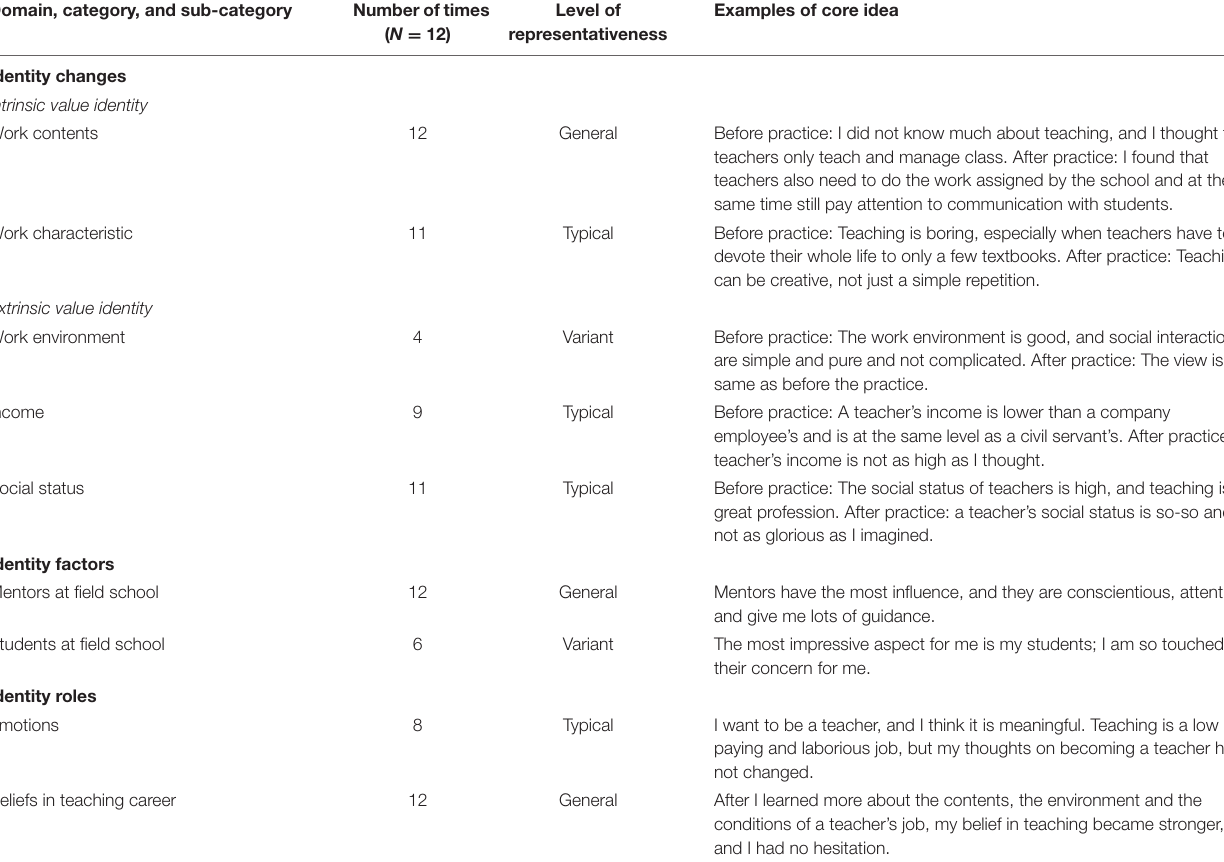
TABLE 3 | The results of the qualitative research: representativeness and examples of domain, category, and sub-category. Domain, category, and